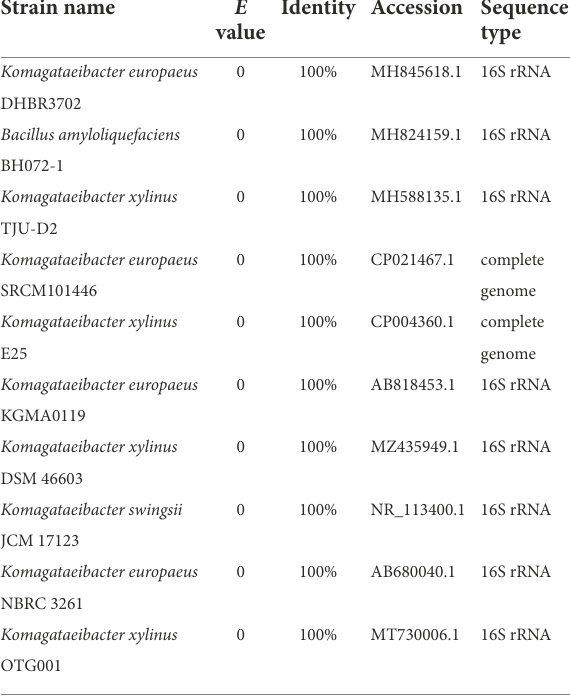
TABLE 2 Top 10 hits of online BLASTn search using the sequence of 16S rRNA PCR product amplified from the samples in this study as the